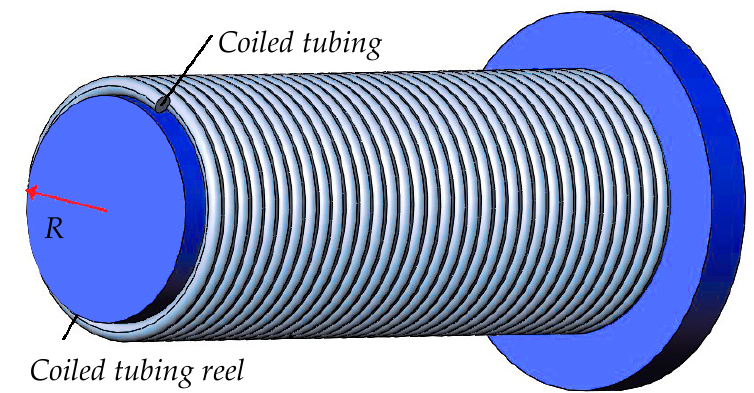
Figure 1. Schematic diagram of one-layer CT.